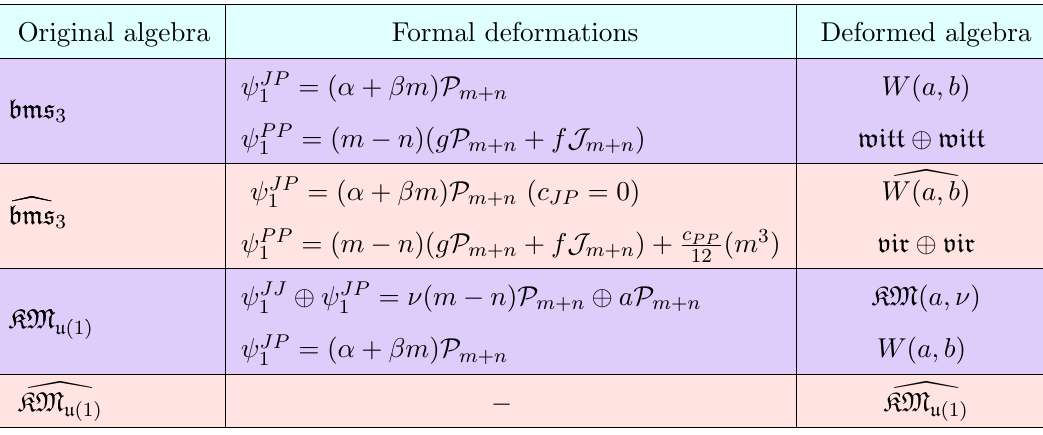
Table 1 . In(cid:12)nitesimal and formal deformations and the 2-cocycles of bms 3 , d bms 3 , KM \ KM u (1)